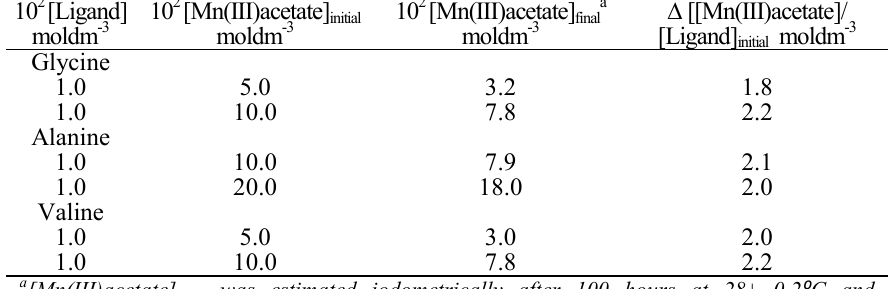
Table 3. First order rate constants for Mn(III)acetate of Co(III)complexes of α-amino acids in NaLS at 28±0.2 o C. The formation constants for Mn(III)acetate of Co(III)complexes of α -amino acids in NaLS along with the limiting specific rates. Mn(III)=1 M, H NaLS=0.01 M, Temp 28±0.2 o C.